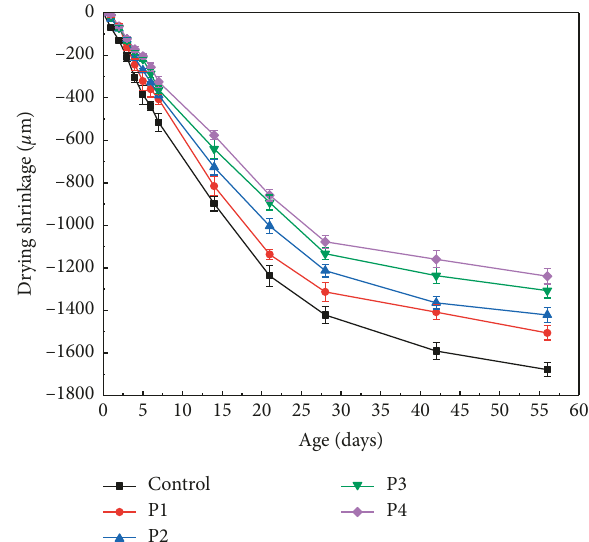
Figure 7: The drying shrinkage of AAS mortars vs. curing time. The error bars represent the standard deviation of three test